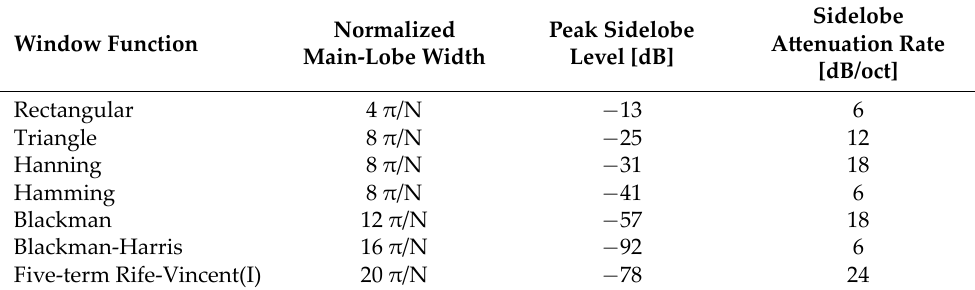
Table 1. The five‑term R‑V window function coefficients. Coefficient b 0 b 1 b 2 b 2 b 4 Five‑term 1 1.6 0.8 0.22857 0.02857 Rife‑Vincent(I)